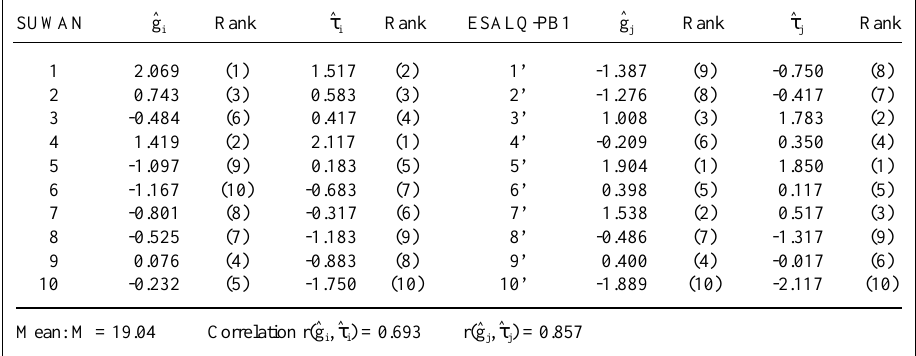
Table IX - Estimates of the mean (m), GCA (g i , g j ) and line combining ability ( t i , t j ) effects for crosses between two maize populations. SUWAN